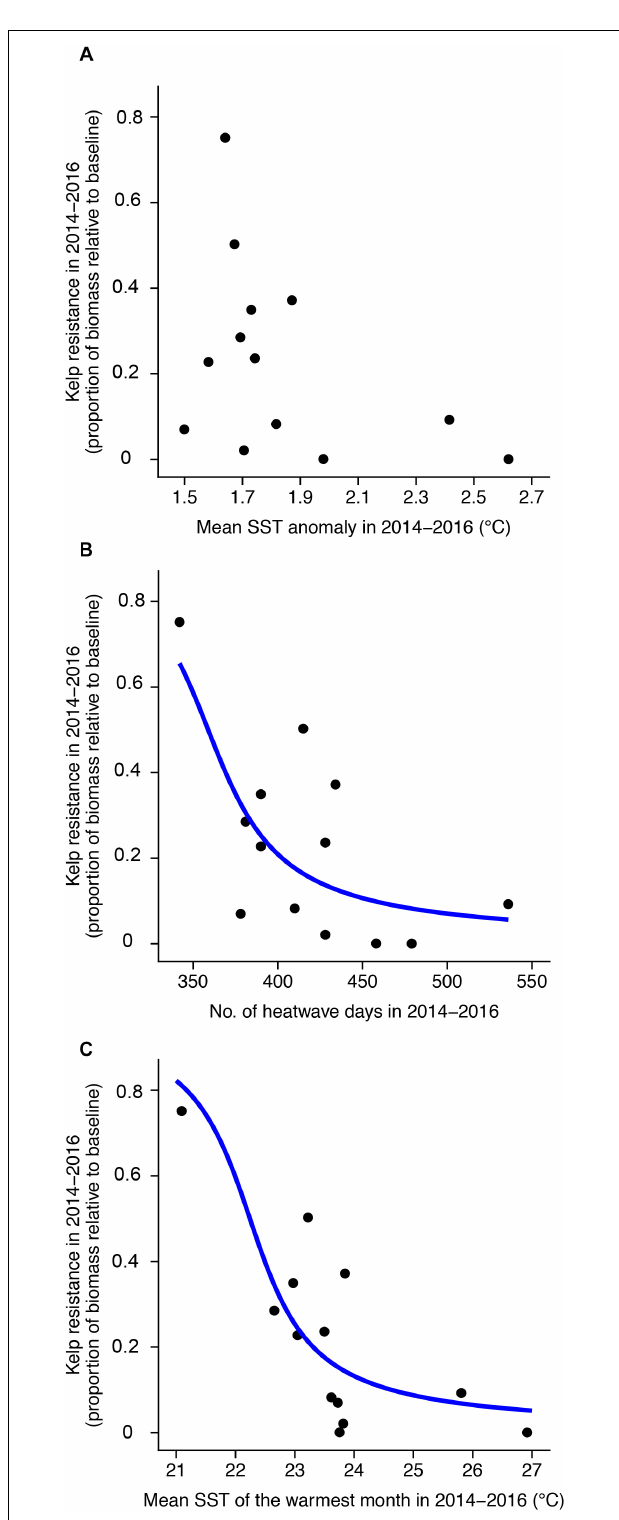
FIGURE 7 | Relationship between kelp resistance and 2014–2016 sea surface temperature metrics: (A) SST anomaly, (B) number of heatwave days, and (C) mean SST of the warmest month. Blue lines show beta regression model fits for significant relationships ( p < 0.05).